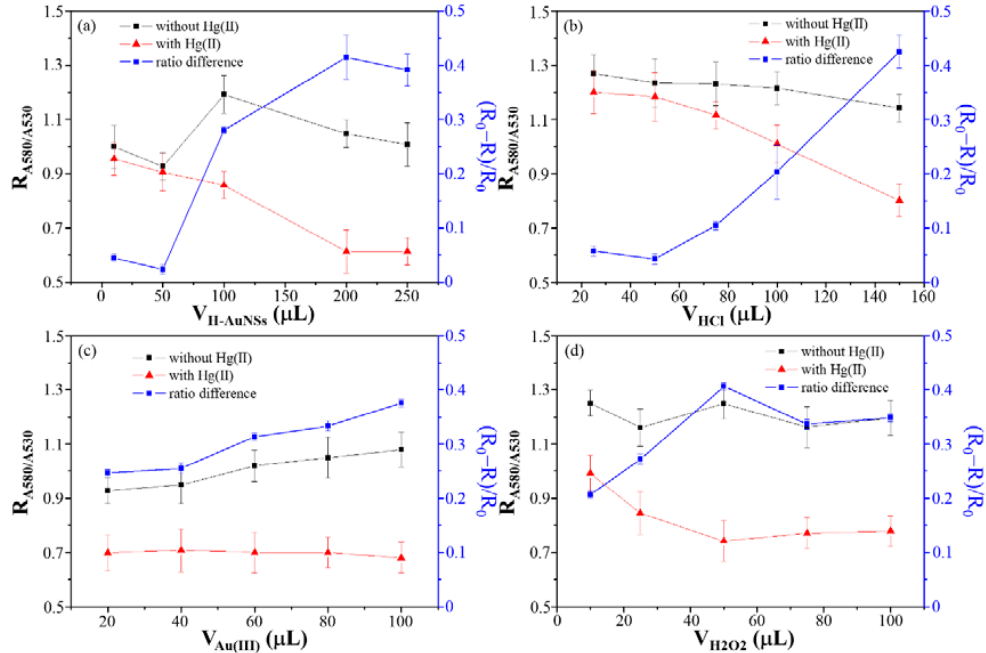
Figure 6. SPR band ratios (R: A 580 /A 530 ) to evaluate the catalytic effects of the H-AuNS probe ( ■ ) on AuNP growth without ( ■ ) and with ( ▲ ) of Hg(II) (1.0 µM) in the presence of HCl/Au(III)/H 2 O 2 solution, at different volumes of ( a ) H-AuNSs, ( b ) HCl, ( c ) Au(III), and ( d ) H 2 O 2 . Error bars represent standard deviations from three repeated experiments.